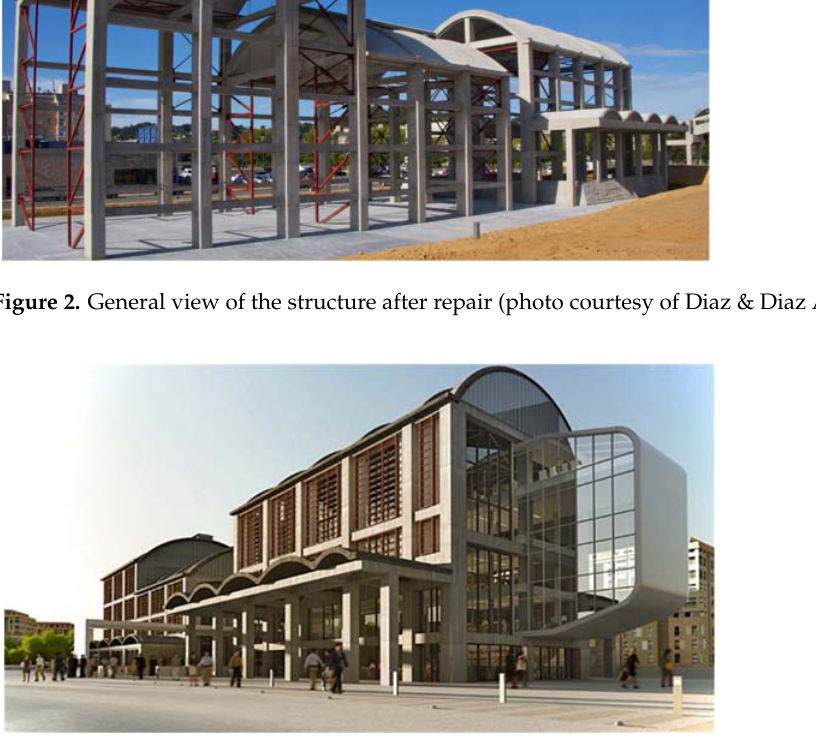
Figure 2. General view of the structure after repair (photo courtesy of Diaz & Diaz Architects S.L.).